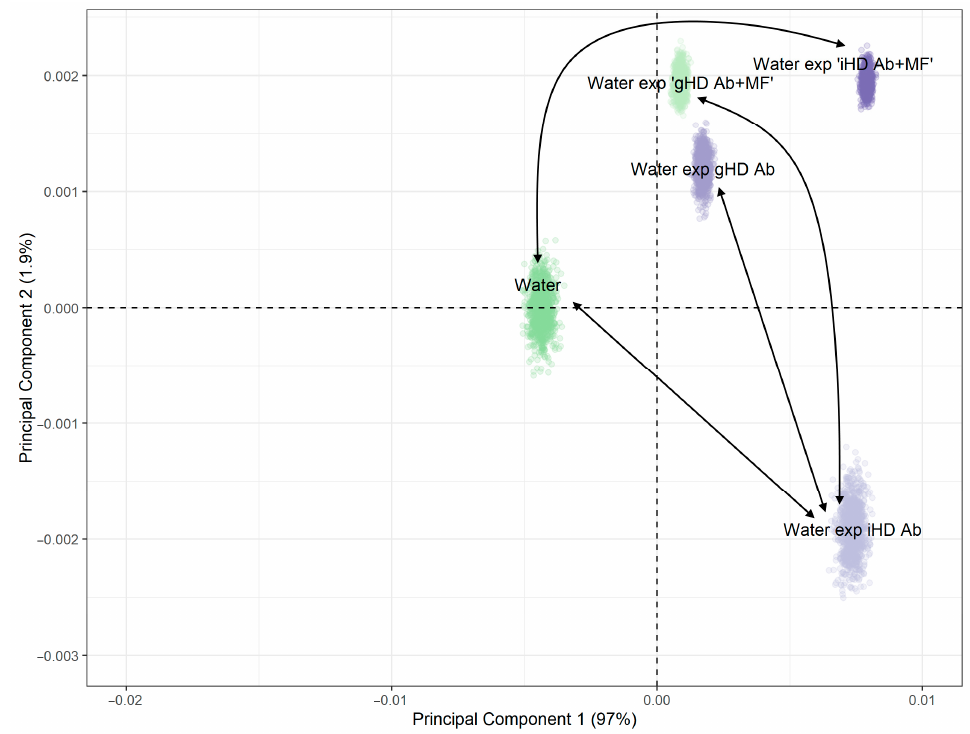
Figure 9. The influence of non-contact impact of iHD Ab and gHD Ab treated with a magnetic field on the distribution of water samples spectra in the wavelength range of 470–2000 cm − 1 in the space of the principal components. In sample labels, ‘exp’ means ‘exposed to’, ‘+MF’ means ‘treated with a magnetic field’. Data are presented as mean ± SD. Double-sided arrows depict statistically significant differences in the emission spectra between the parenthetical groups ( p < 0.05, comparison of the K-means with the Holm correction).